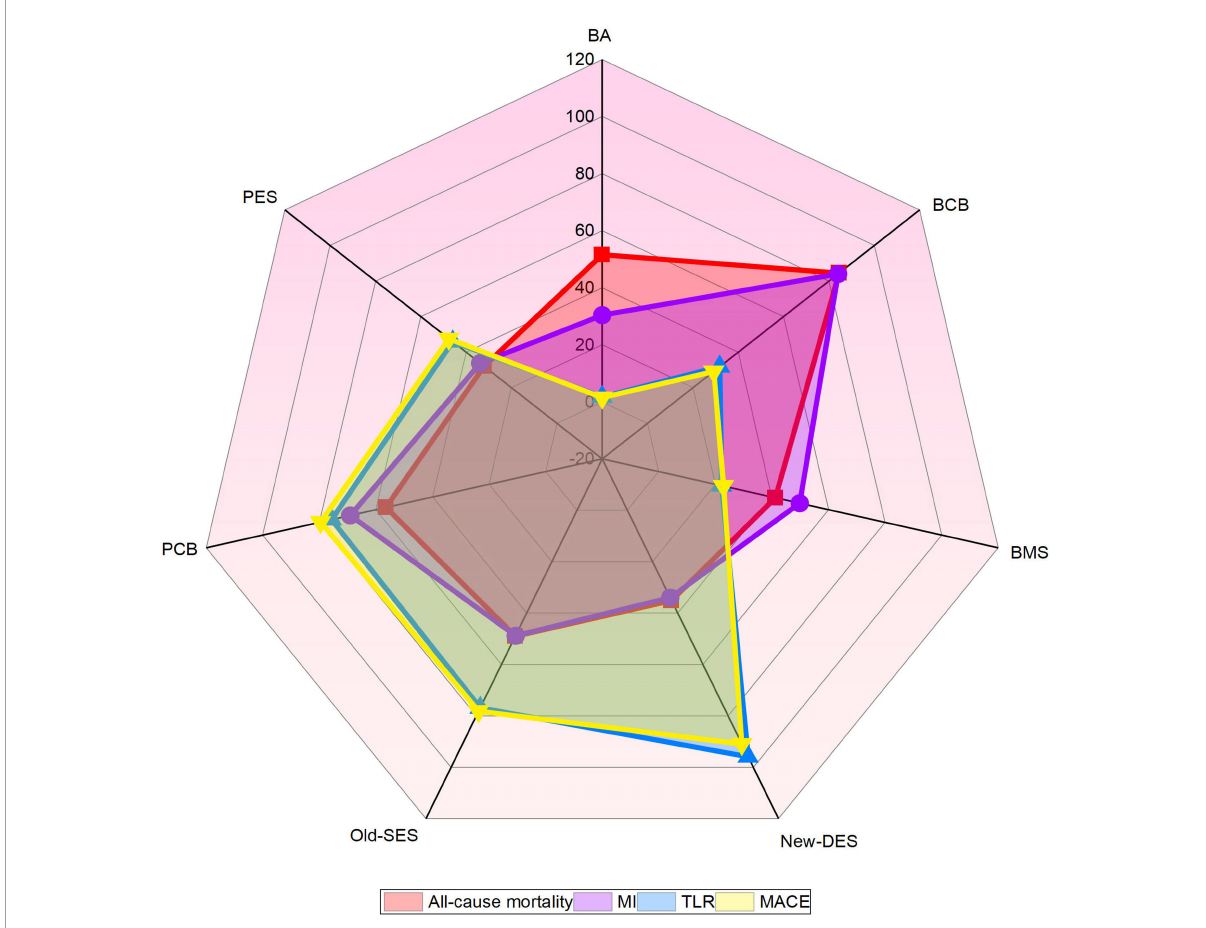
FIGURE3 Radar map of ranked intervention strategies in all clinical outcomes. The different colored labeled points represent the SUCRA of each intervention strategy for different clinical outcomes. BA, balloon angioplasty; BCB, biolimus-coated balloon; BMS, bare-metal stent; MACE, major adverse cardiac events; MI, myocardial infarction; New-DES, new-generation drug-eluting stent; Old-SES, older generation sirolimus-eluting stent; PCB, paclitaxel-coated balloon; PES, paclitaxel-eluting stent; TLR, target lesion